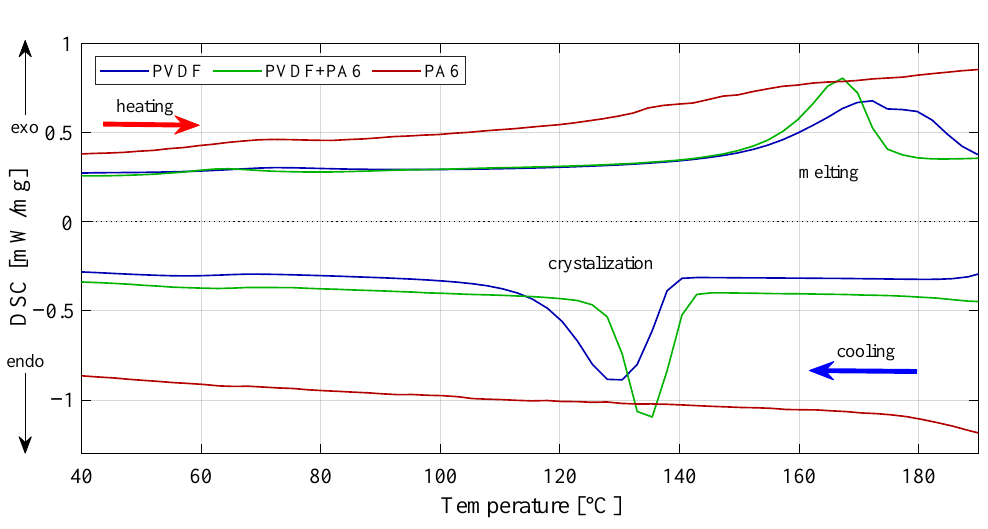
Figure 6. Exothermic and endothermic reactions can be observed from DSC curves. All three materials are presented here. Results are mainly used to calculate enthalpies of transitions by integrating the peak corresponding to a given transition. In this case, PVDF and PVDF/PA6 mixture only can be